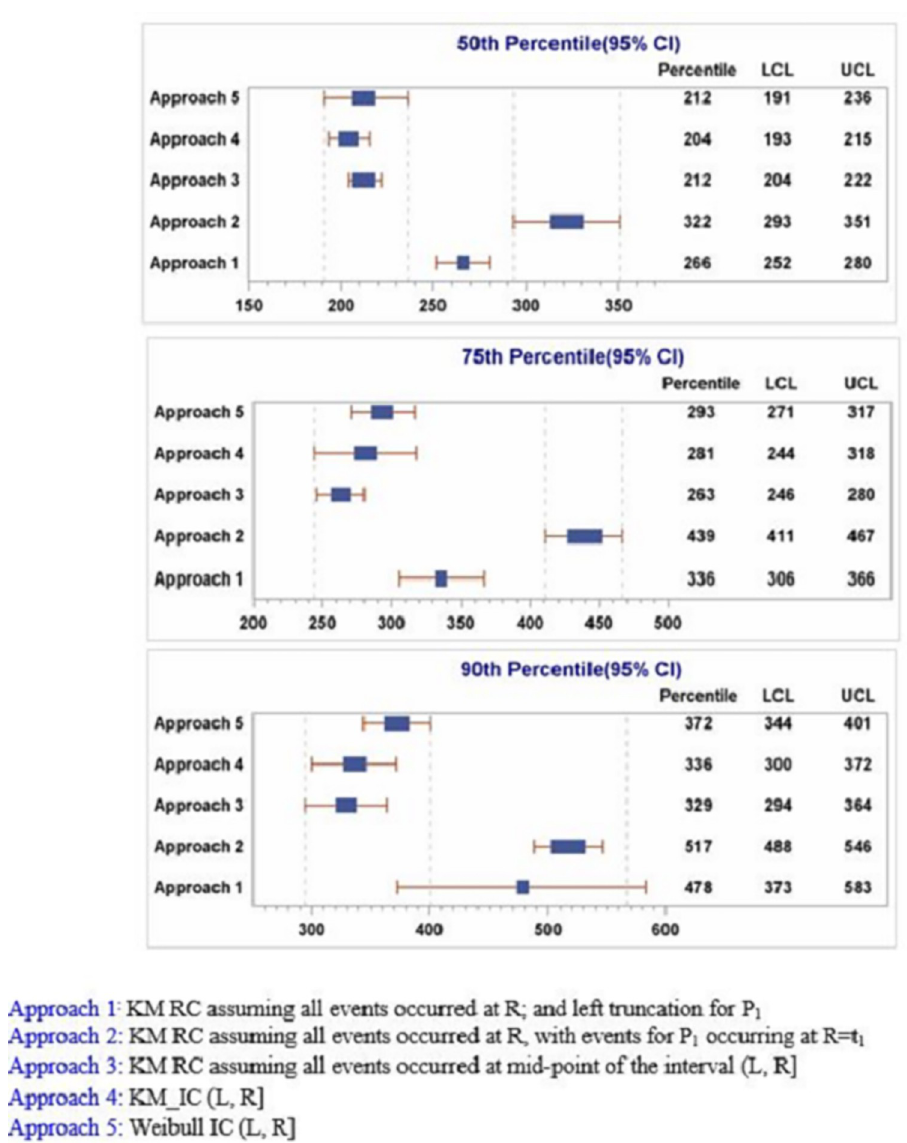
Fig 3. Comparison of the performance of the five non-parametric and parametric models in estimating percentiles (95%CI) for EBOV confirmed negativity in semen.